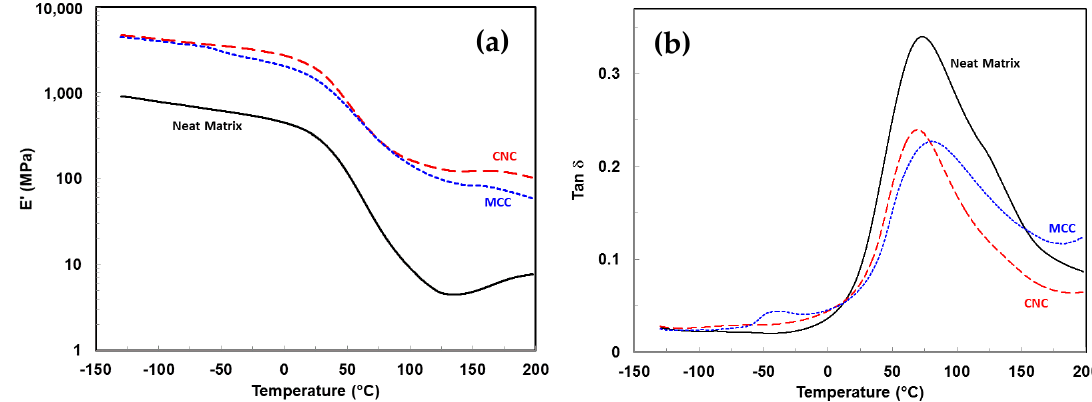
Figure 3. ( a ) Storage modulus (E’) and ( b ) loss angle tangent (tan δ ) versus temperature for the neat lignopolyurethane and lignopolyurethane composites reinforced with cellulose nanocrystals (CNC) and microcrystalline cellulose (MCC).